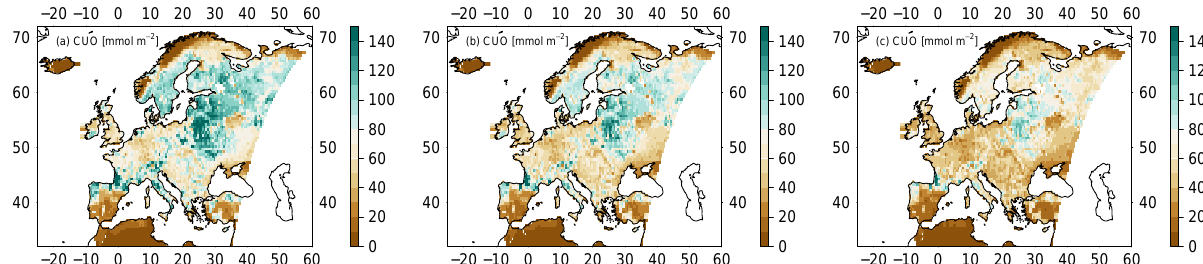
Figure 9. Mean decadal canopy-integrated cumulative uptake of O 3 (CUO) (mmolm − 2 ) for Europe of the years 2001–2010. (a) Canopy O 3 concentration is equal to the atmospheric concentration (ATM) and (b) O 3 surface resistance is only determined by stomatal resistance (D-STO). (c) Standard ozone deposition scheme